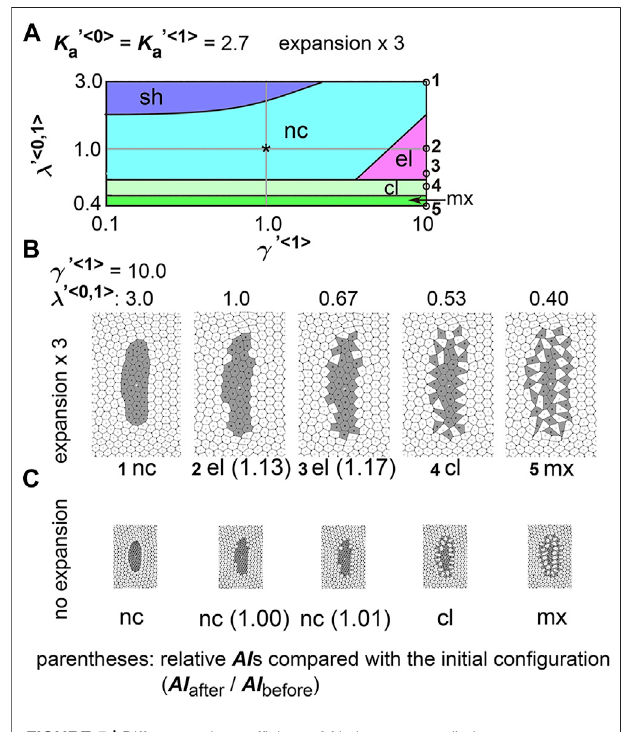
FIGURE 5 | Differences in coef fi cient of friction cause cell cluster elongation on an expanding fi eld. Simulations were performed under conditions with various values of the coef fi cient of the friction, whereas values for the area elasticity were assigned to be equal for both two cell types: γ < 0 > ≠ γ < 1 > ,whereas K < 0 > (cid:1) K < 1 > a a .Thelinetensionsinthetype0andtype 1 cells were made equal in value, whereas the line tension between the type 0 and type 1 cells was different: λ < 0 , 0 > (cid:1) λ < 1 , 1 > ≠ λ < 0 , 1 > . The fi elds were expanded by three times in area (A,B) or not expanded (C) . A phase diagram and examples of simulation outcomes were shown under K ′ < 0 > a (cid:1) 2 . 7. The parameter values used for each condition in B are plottedonthediagrams (A) ,withnumberscorrespondingtoeachcondition.A simulation outcome at the condition with an asterisk on the diagram (A) was previously shown in Figure 2B-i . Each phase in the diagrams is colored as follow: “ el ” , pink; “ sh ” , blue; “ nc ” , light blue; “ cl ” , light green; “ mx ” , green. The parameter values except for the fi eld expansion were set to be the same between B and C. The scales of the images in (B,C) are the same each other. Other simulation outcomes obtained with different area elasticity values are shown in Supplementary Figure S5